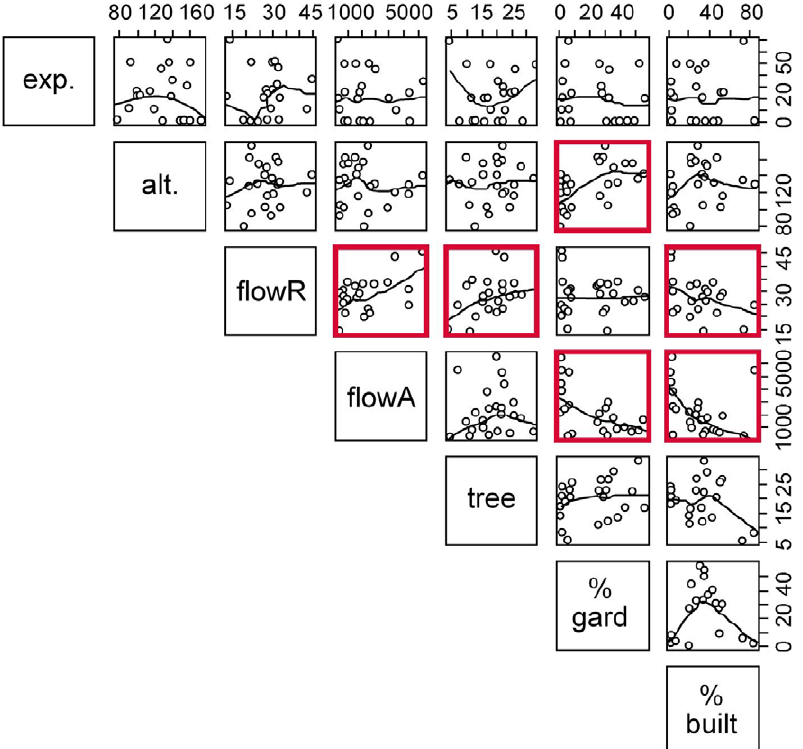
Figure 3. Co-plot showing relationships between explanatory variables used in the generalized linear models. Pairwise scatterplots are shown with locally weighted loess smoothing to aid visual interpretation and panels with a Pearson correlation . 0.3 highlighted. Variable codes are abbreviated for clarity (exp. =% exposure, alt. = altitude in metres, flowR = flowering forb species richness, flowA = flowering forb flower abundance, tree = number of flowering trees, % gard. =% gardens within 500m, and% built =% built space within 500m). Percentage gardens and built space at 500m scale was used as an example because this was most representative of these variables at all wider landscape scales.